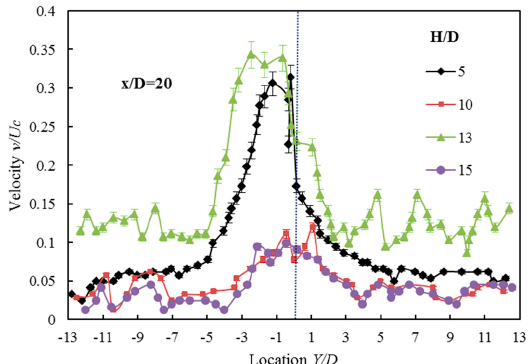
Figure 11. Radial turbulent intensity of the horizontal plane ( X - Y ).